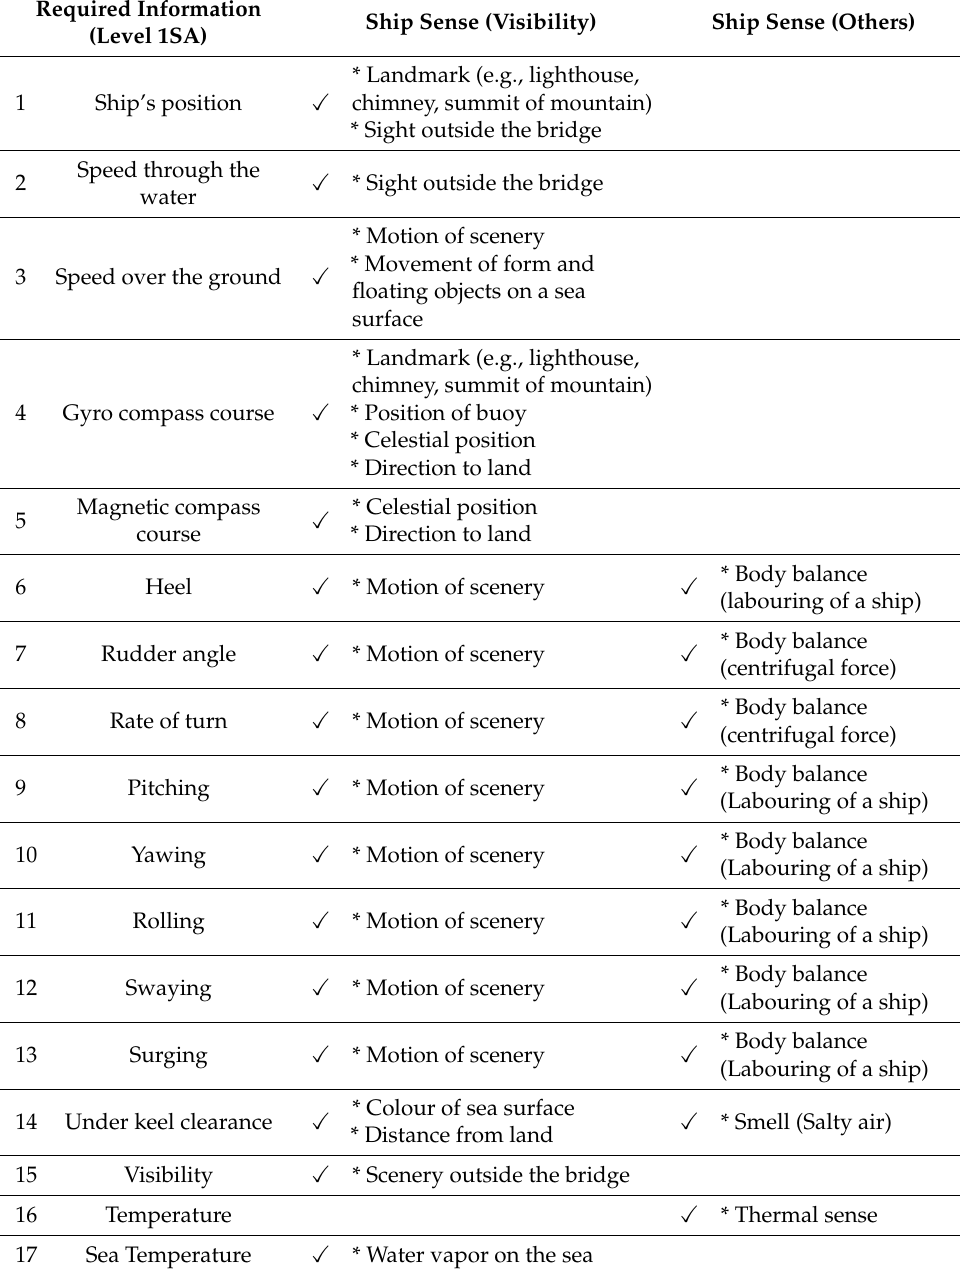
Table 6. Linkage between required information for Level 1 SA and ship